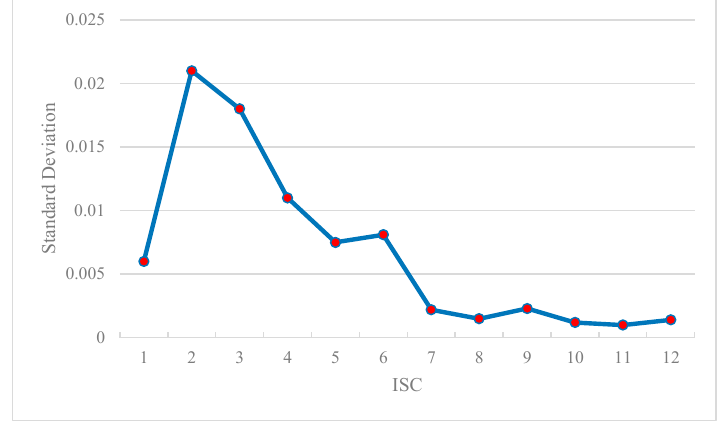
Figure 8. Standard deviation of amplitude.